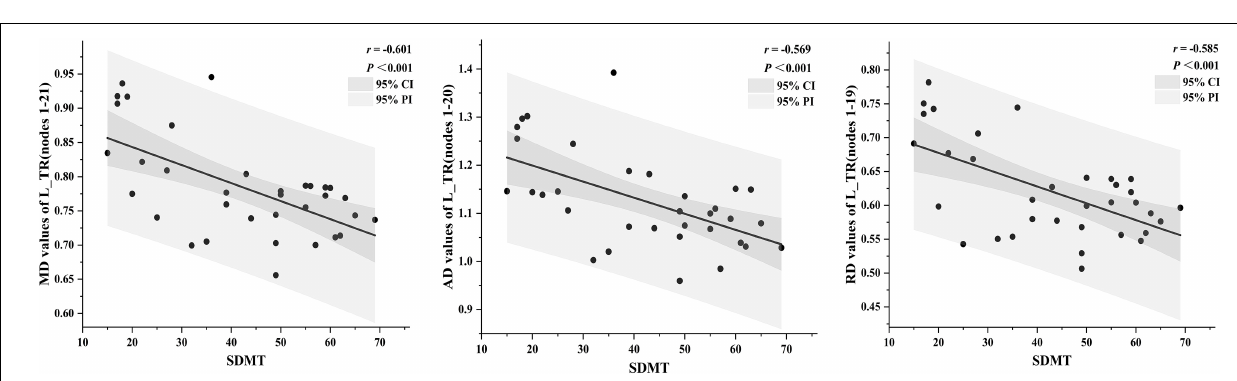
Frontiers in Neuroscience |